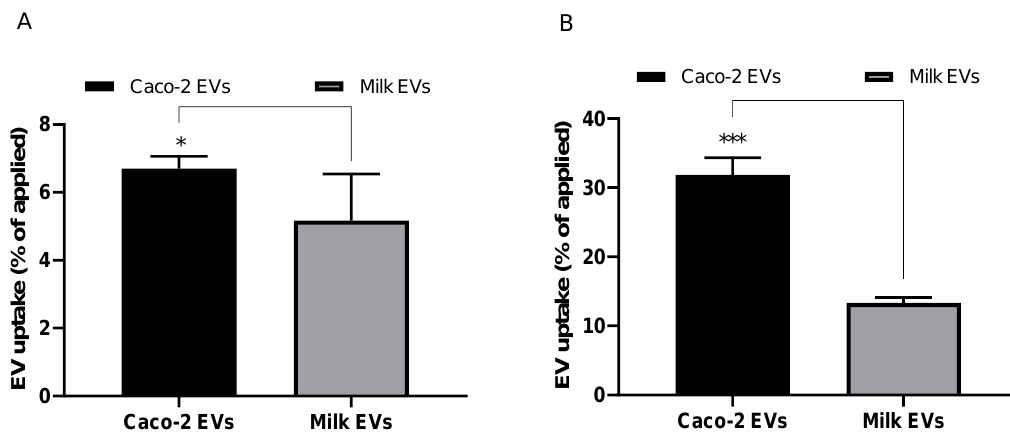
Figure 2. Cell uptake of extracellular vesicles (EVs) (expressed as EV protein amount) in undi ff erentiated and di ff erentiated Caco-2 cells. ( A ) Cell uptake (percentage of applied dose) of milk-derived and Caco-2 derived EVs in undi ff erentiated Caco-2 cells cultured on 48-well plates. Cells were incubated with EVs for fourh. Data shown as the mean +/ − SD ( n = 3). * denotes p < 0.05. ( B ) Cell uptake of milk-derived and Caco-2-derived EVs in Caco-2 di ff erentiated / polarised cells. Cells were cultured for 21 days on permeable inserts. Cells were incubated with EVs for fourh. Data shown as the mean +/ − SD ( n = 3). *** denotes p < 0.001.